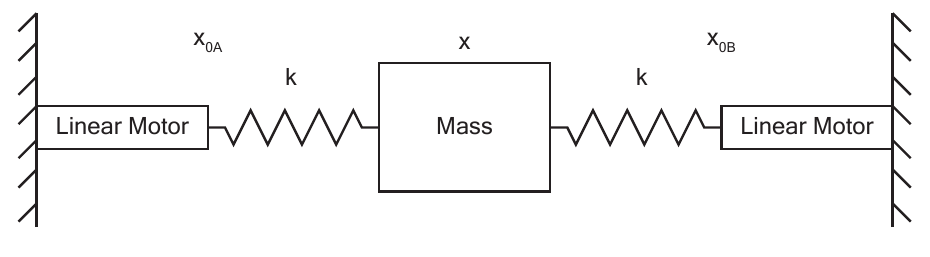
Figure 14. Demonstration of the uncontrollable linear springs.